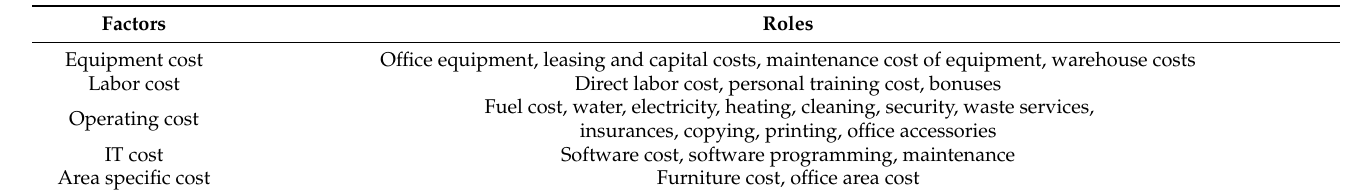
Table 9. Cost factors and